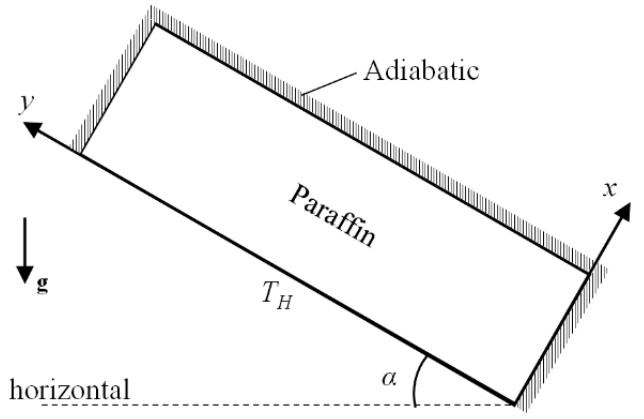
Figure 2. Physical model.